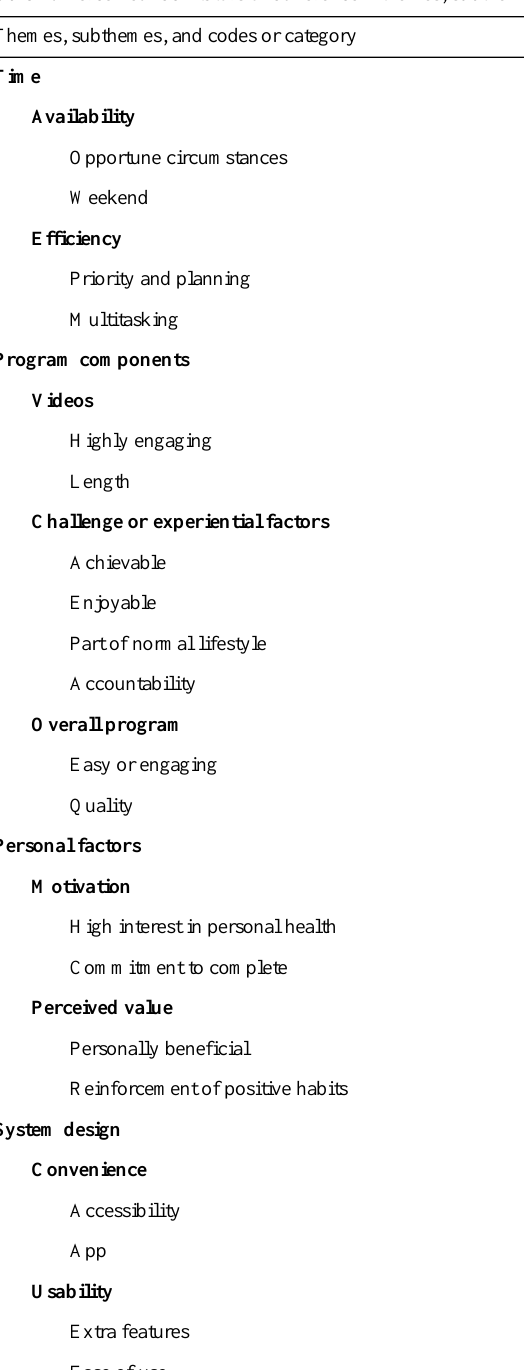
Table 1. Perceived facilitators of adherence—themes, subthemes, and codes.